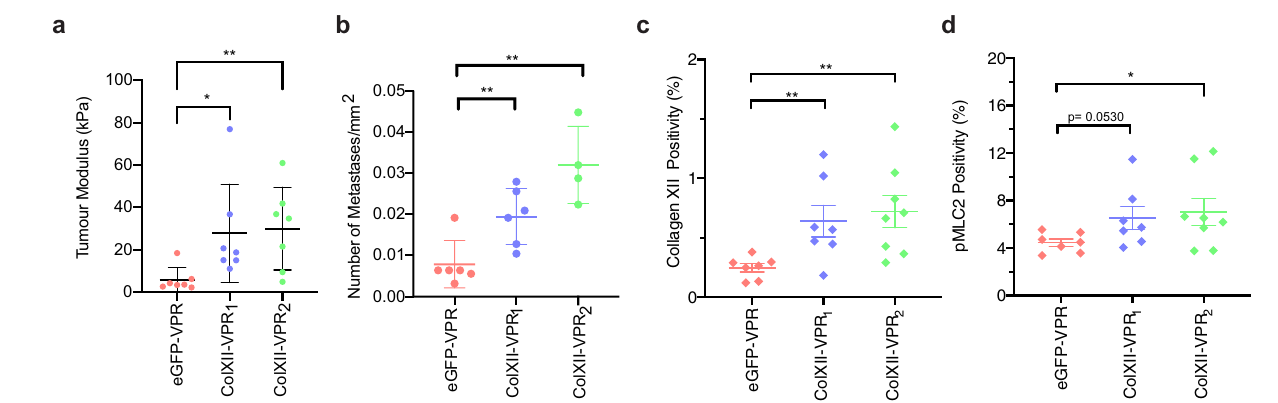
Fig. 9 | Collagen XII overexpression promotes metastasis in vivo. a Bulk mod- ulus as determined by uncon fi ned compression analysis of excised primary tumoursgenerated byco-implantationof cancercellswithcontrol(eGFP-VPR)and collagenXII overexpressing (ColXII-VPR 1 , ColXII-VPR 2 ) CAFs. Data are presented as mean±SD, n =7 eGFP-VPR mice, n =7 ColXII-VPR 1 and n =8 ColXII-VPR 2 mice, * p =0.017,** p =0.0066,Kruskal – WallistestwithDunn ’ smultiplecomparisonstest. b Quanti fi cationofmeannumberofmetastasesnormalisedtothetotallungareain mice with metastases present in the overexpression study ( n =6 eGFP-VPR mice, n =6 ColXII-VPR 1 and n =4 ColXII-VPR 2 mice with metastases present). Data are presentedasmean±SD.eGFP-VPRvs.ColXII-VPR 1 p =0.0087;eGFP-VPRvs.ColXII-